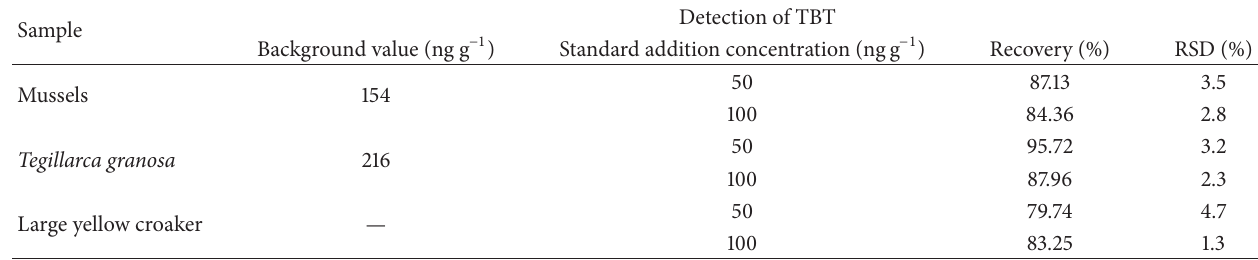
Table 4: Recovery rates and relative standard deviations ( 𝑛 = 4